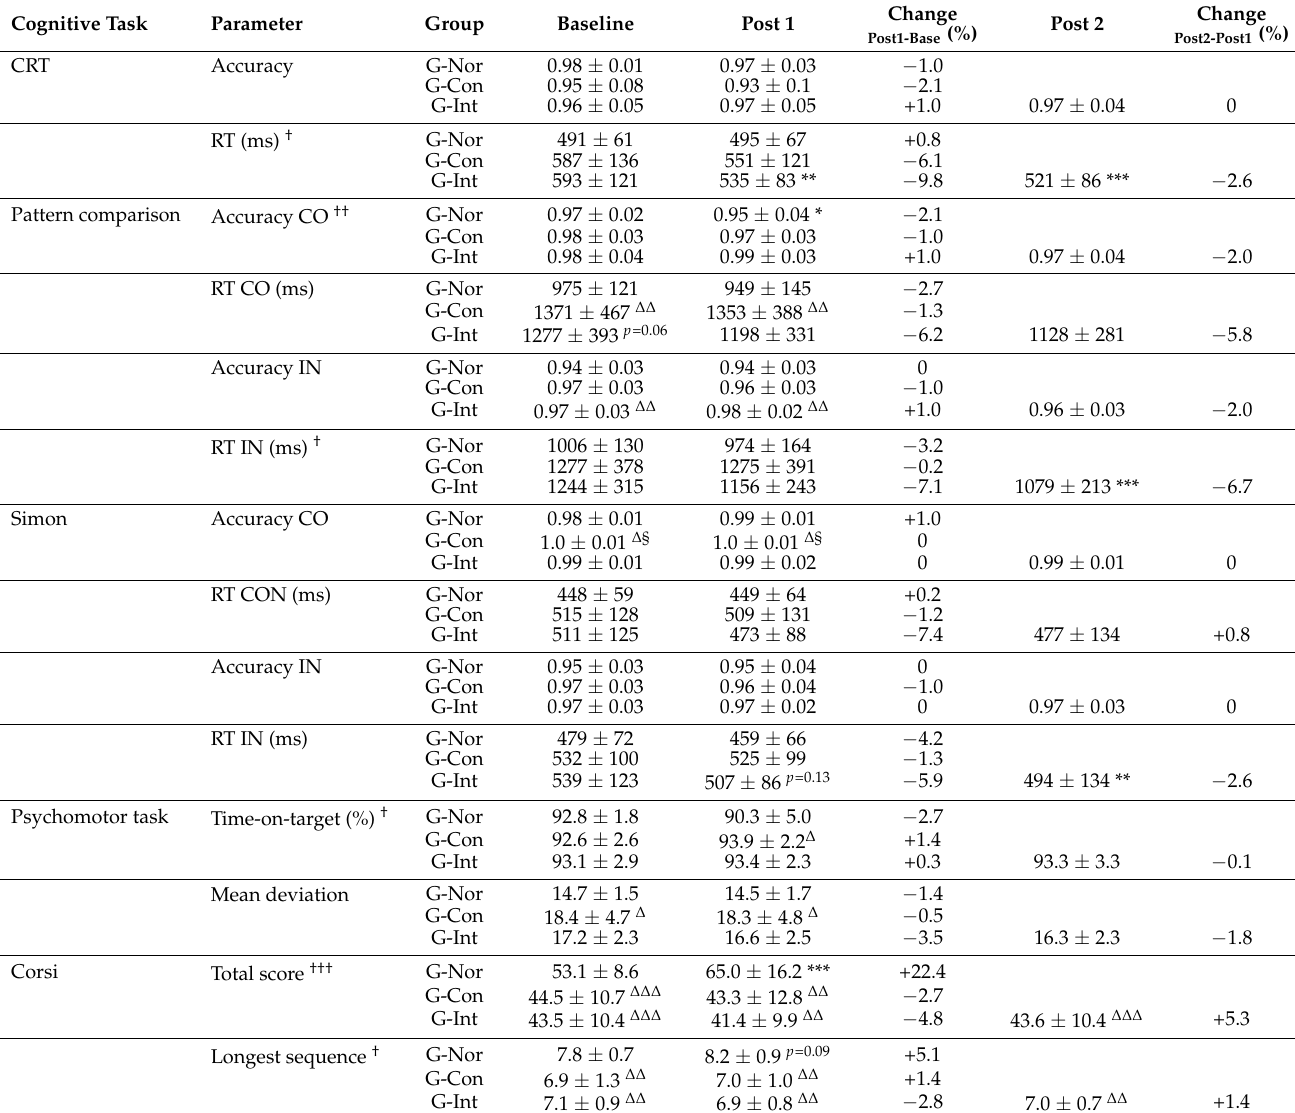
Table 4. Summary of cognitive task